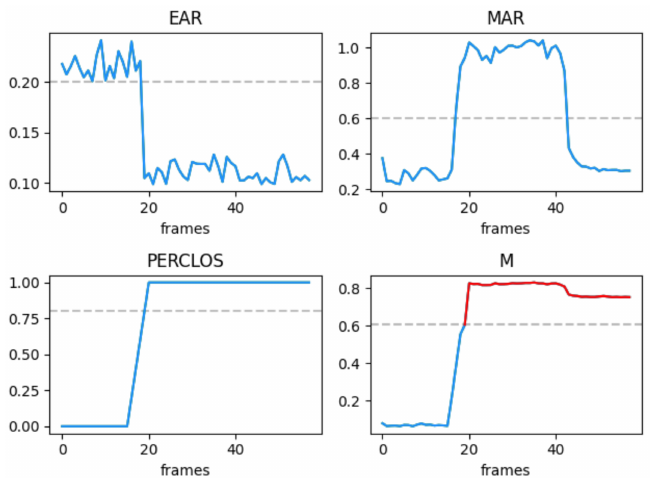
Figure 10. Fatigue test results of the driver with